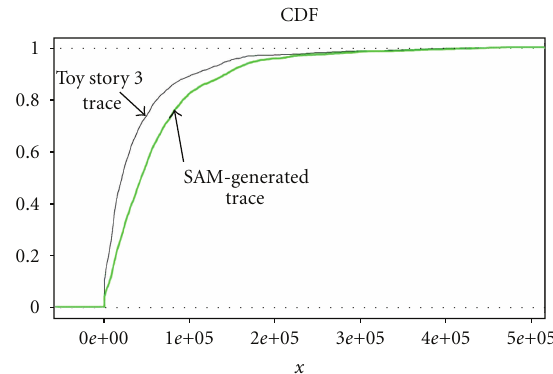
Figure 9: CDF comparison between SAM-generator and actual trace.